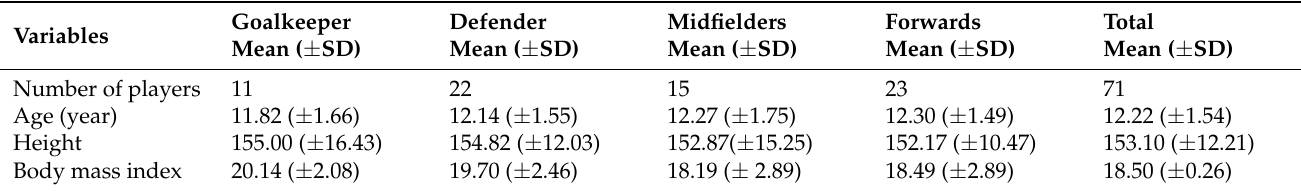
Table 1. Sample age, height, and body mass index by